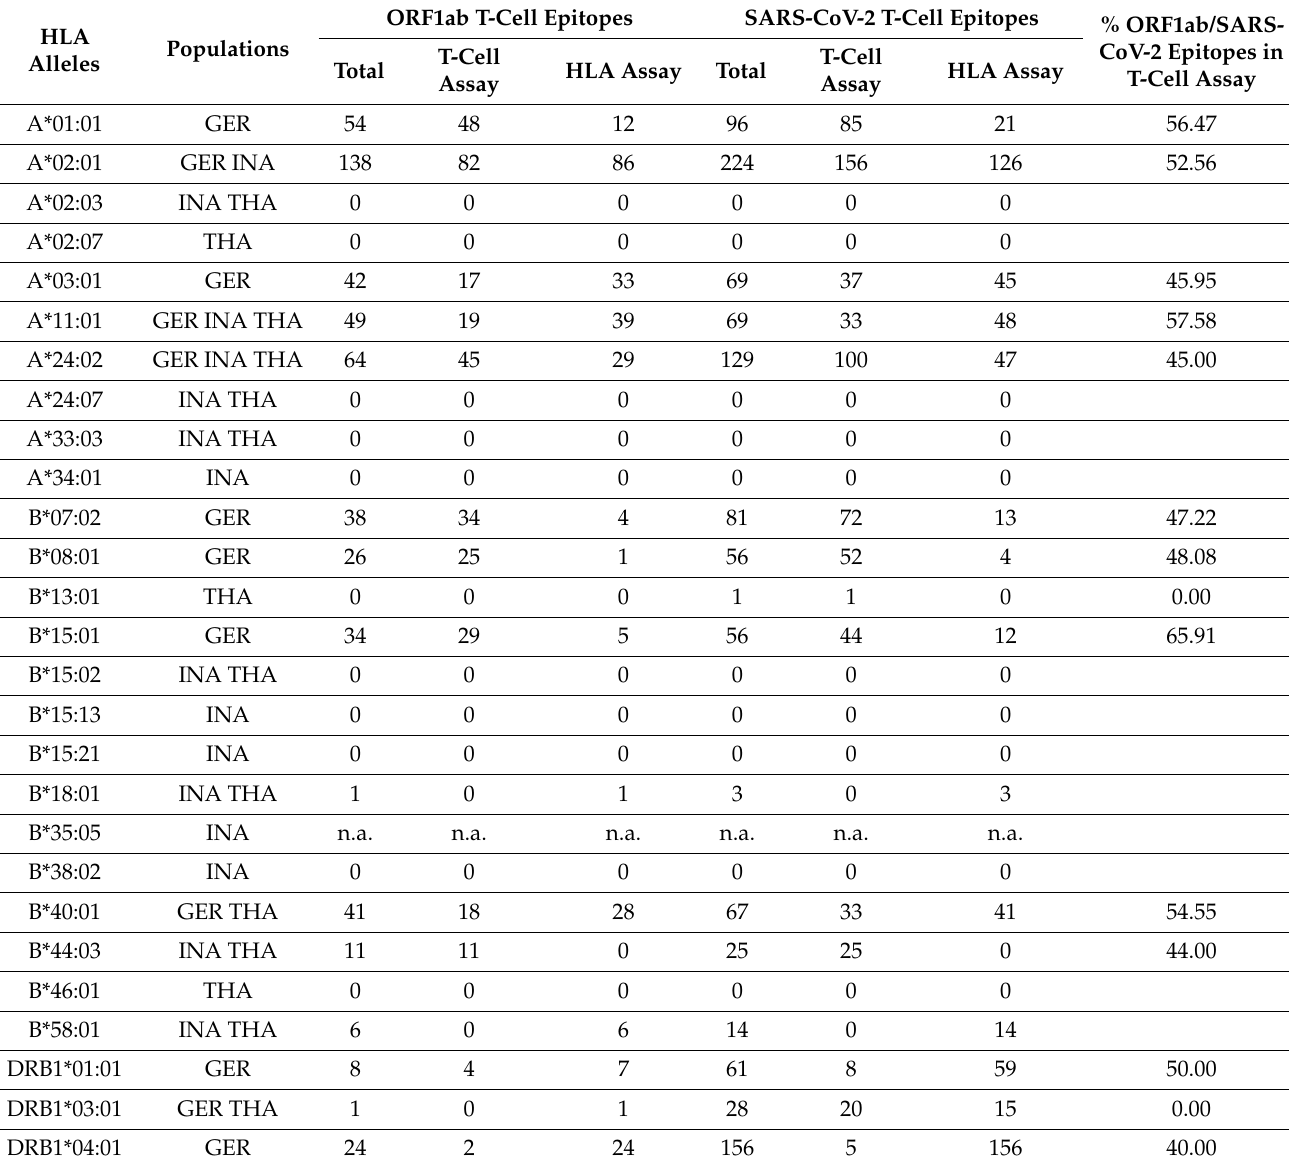
Table 3. The number of experimentally known T-cell epitopes associated with HLA alleles of Indonesia (INA), Thailand (THA), and Germany (GER). The HLA alleles listed are predominant in the Indonesian and Thai populations (allele frequency ≥ 5%). The HLA alleles of the German population are the ones included in a study of T-cell responses to SARS-CoV-2 [25]. The number of immunogenic T-cell epitopes associated with the alleles were extracted from IEDB (accessed on 16 September